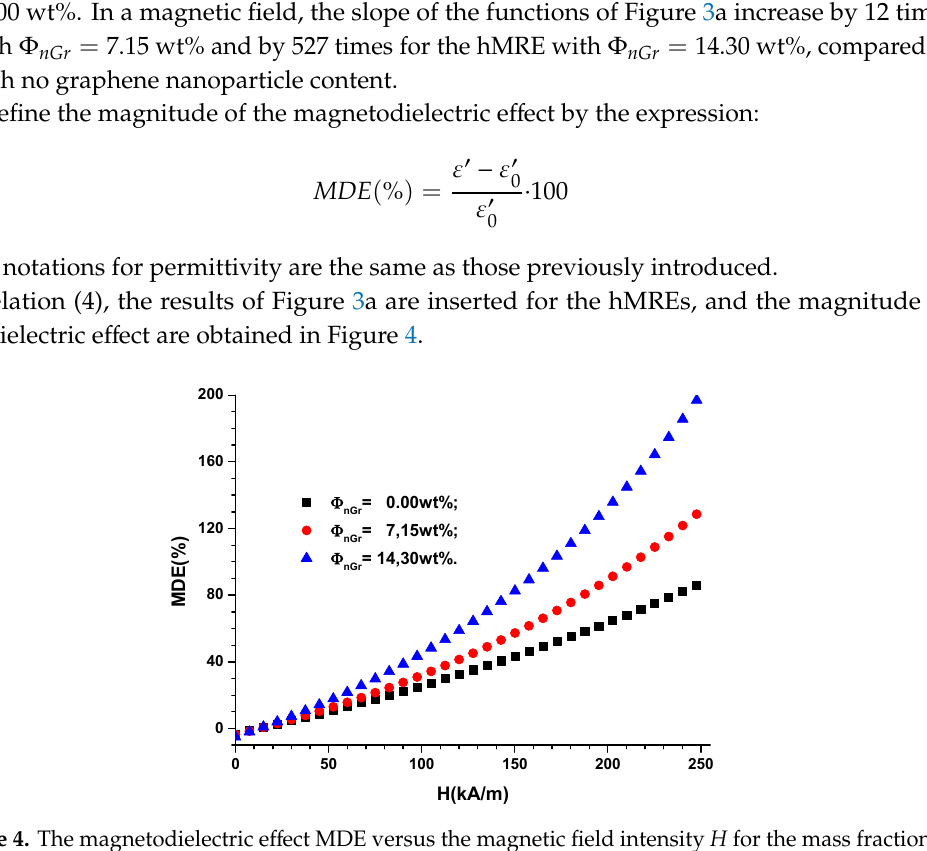
Figure 4. The magnetodielectric e ff ect MDE versus the magnetic field intensity H for the mass fractions Φ nGr of graphene nanoparticles.